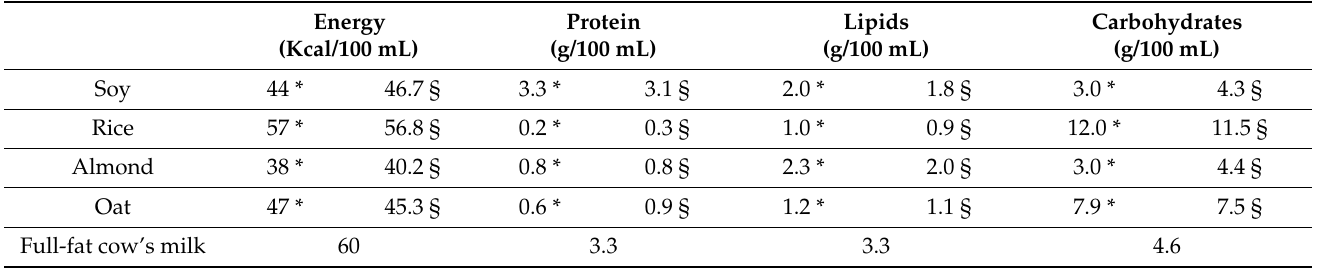
Table 2. Energy and macronutrient composition of plant-based drinks and cow’s milk